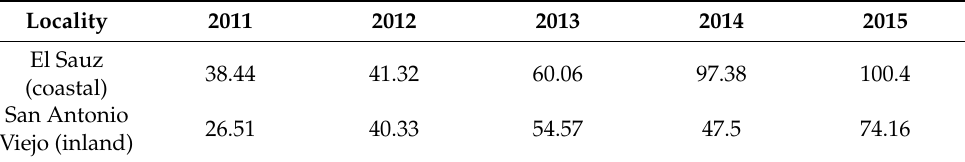
Table 7. Annual precipitation levels (in centimeters) for the two sampling localities for a 5 year period including the years of this study